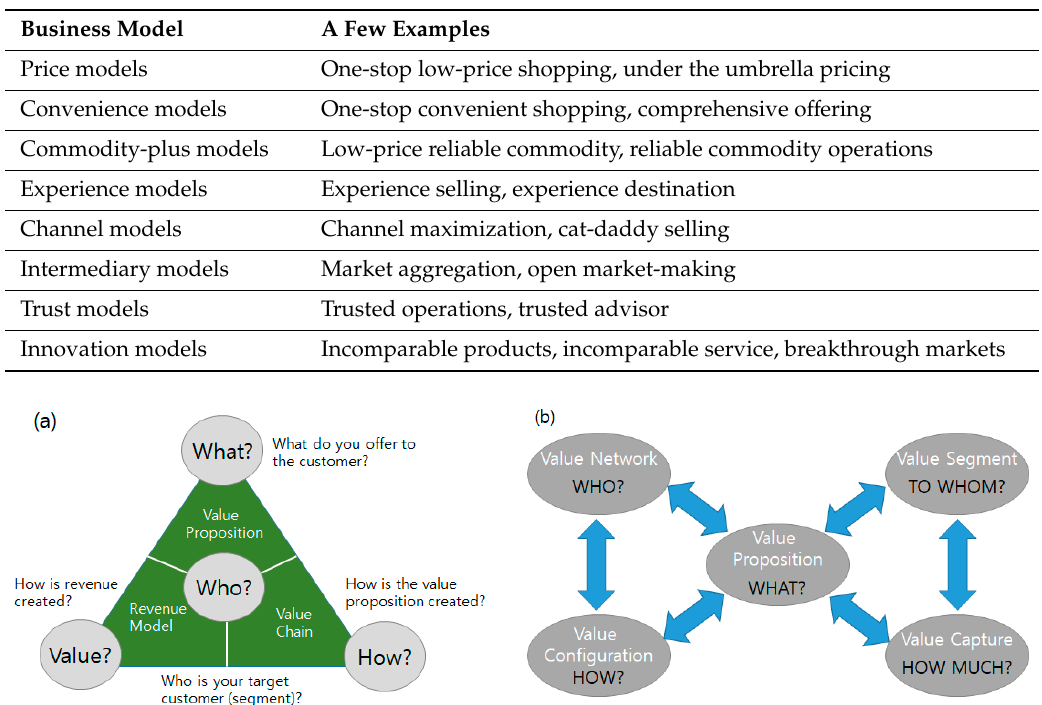
Table 1. Linder and Cantrell’s (2000) [19] eight categorizations of business models.